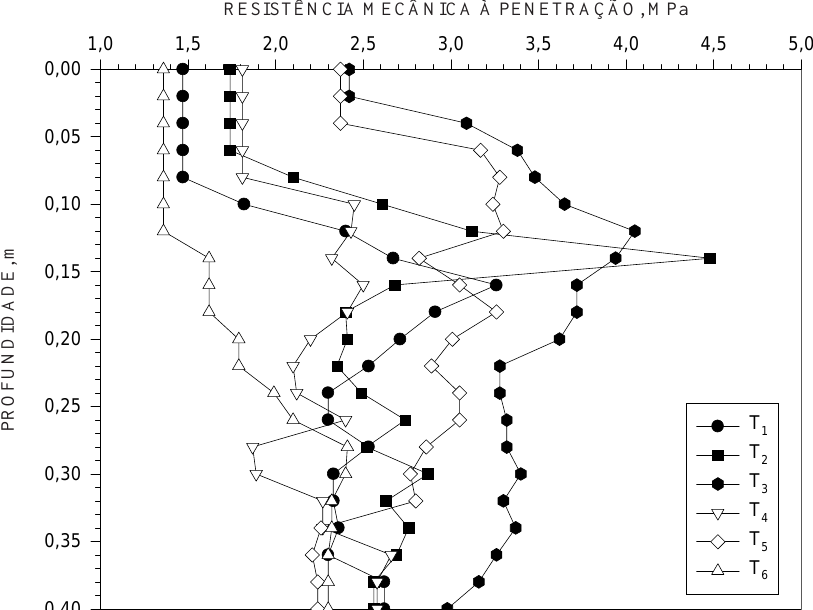
Figura 1. Resistência mecânica do solo à penetração ao longo do perfil do solo para os diferentes sistemas de cultivo estudados (média de 30 determinações). T T - Sistema de cultivo contínuo de arroz; T 2 - Sucessão de culturas: azevém (inverno) x arroz (verão); T T 4 convencional) x arroz (sistema de semeadura direta); T